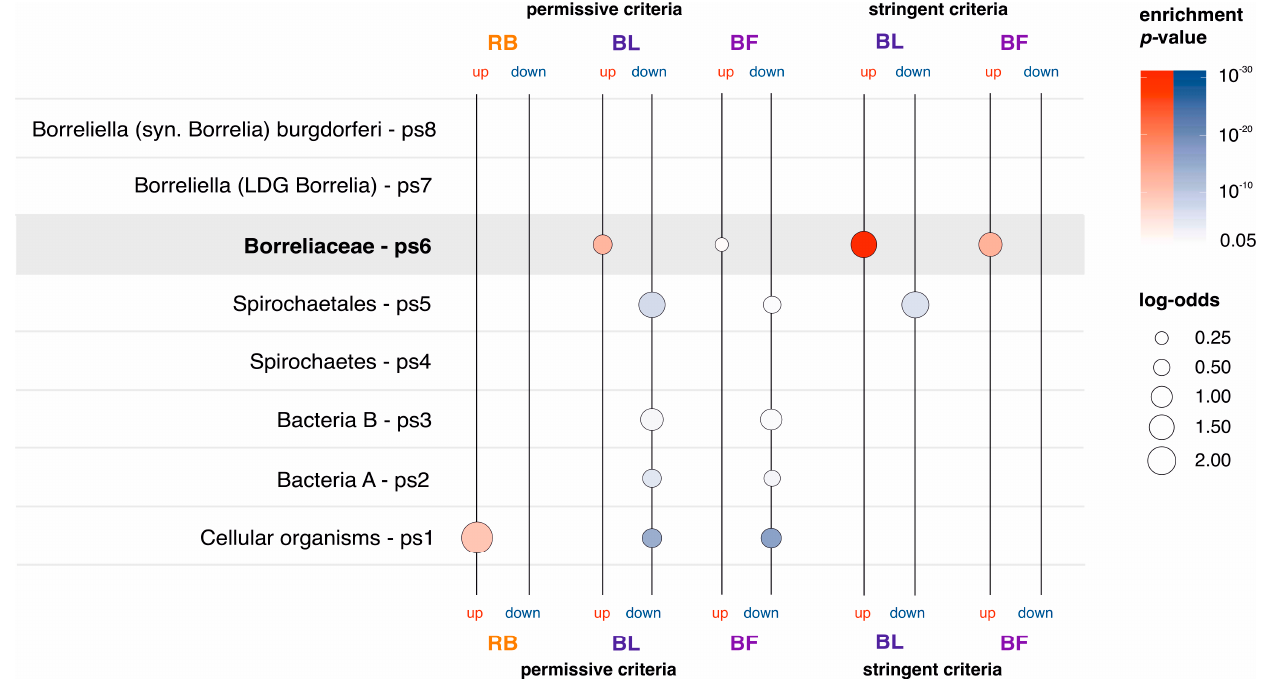
Figure 6. The phylostratigraphic enrichment analysis of differentially expressed genes in B. burgdorferi morphotypes. We showed the enrichment profiles in phylostrata along B. burgdorferi evolutionary lineage for upregulated (up, red color) and downregulated (down, blue color) genes that we detected in the round body (RB), bleb (BL), and biofilm (BF) dominated cultures. We tested the significance of enrichment by two-tailed hypergeometric test corrected for multiple comparisons at 0.05 level (Table S11). Differentially expressed genes were determined in reference to spirochetes using DeSeq2 pairwise comparisons. Under permissive criteria, we considered a gene to be differentially expressed if the shift in its expression was statistically significant ( p < 0.05). Under stringent criteria, we additionally required that the magnitude of change was at least twofold. Under the stringent criteria, there were no differentially expressed genes in round bodies, thus the enrichment analysis was not performed. The magnitude of enrichments within a phylostratum is depicted by log-odds (circles of different sizes) and their significance is shown in color shades ( p -values). Gray shaded area marks phylostratum 6 ( Borreliaceae ) where we found strong enrichment signals for bleb and biofilm upregulated genes.